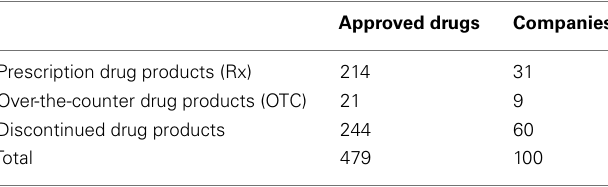
Table 1 |Approved drug products containing acetaminophen as an active ingredient.